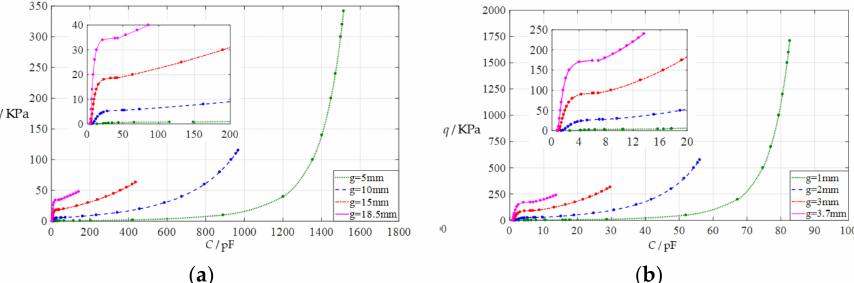
Figure 8. The capacitance–pressure relationships of a circular capacitive pressure sensor from non-touch mode of operation to touch mode of operation: ( a ) for a = 50 mm, h = 1 mm, t = 0.1 mm, E = 7.84 MPa, ν = 0.47, and g = 5 mm, 10 mm, 15 mm, and 18.5 mm; ( b ) for a = 10 mm, h = 1 mm, t = 0.1 mm, E = 7.84 MPa, ν = 0.47, and g = 1 mm, 2 mm, 3 mm, and 3.7 mm.